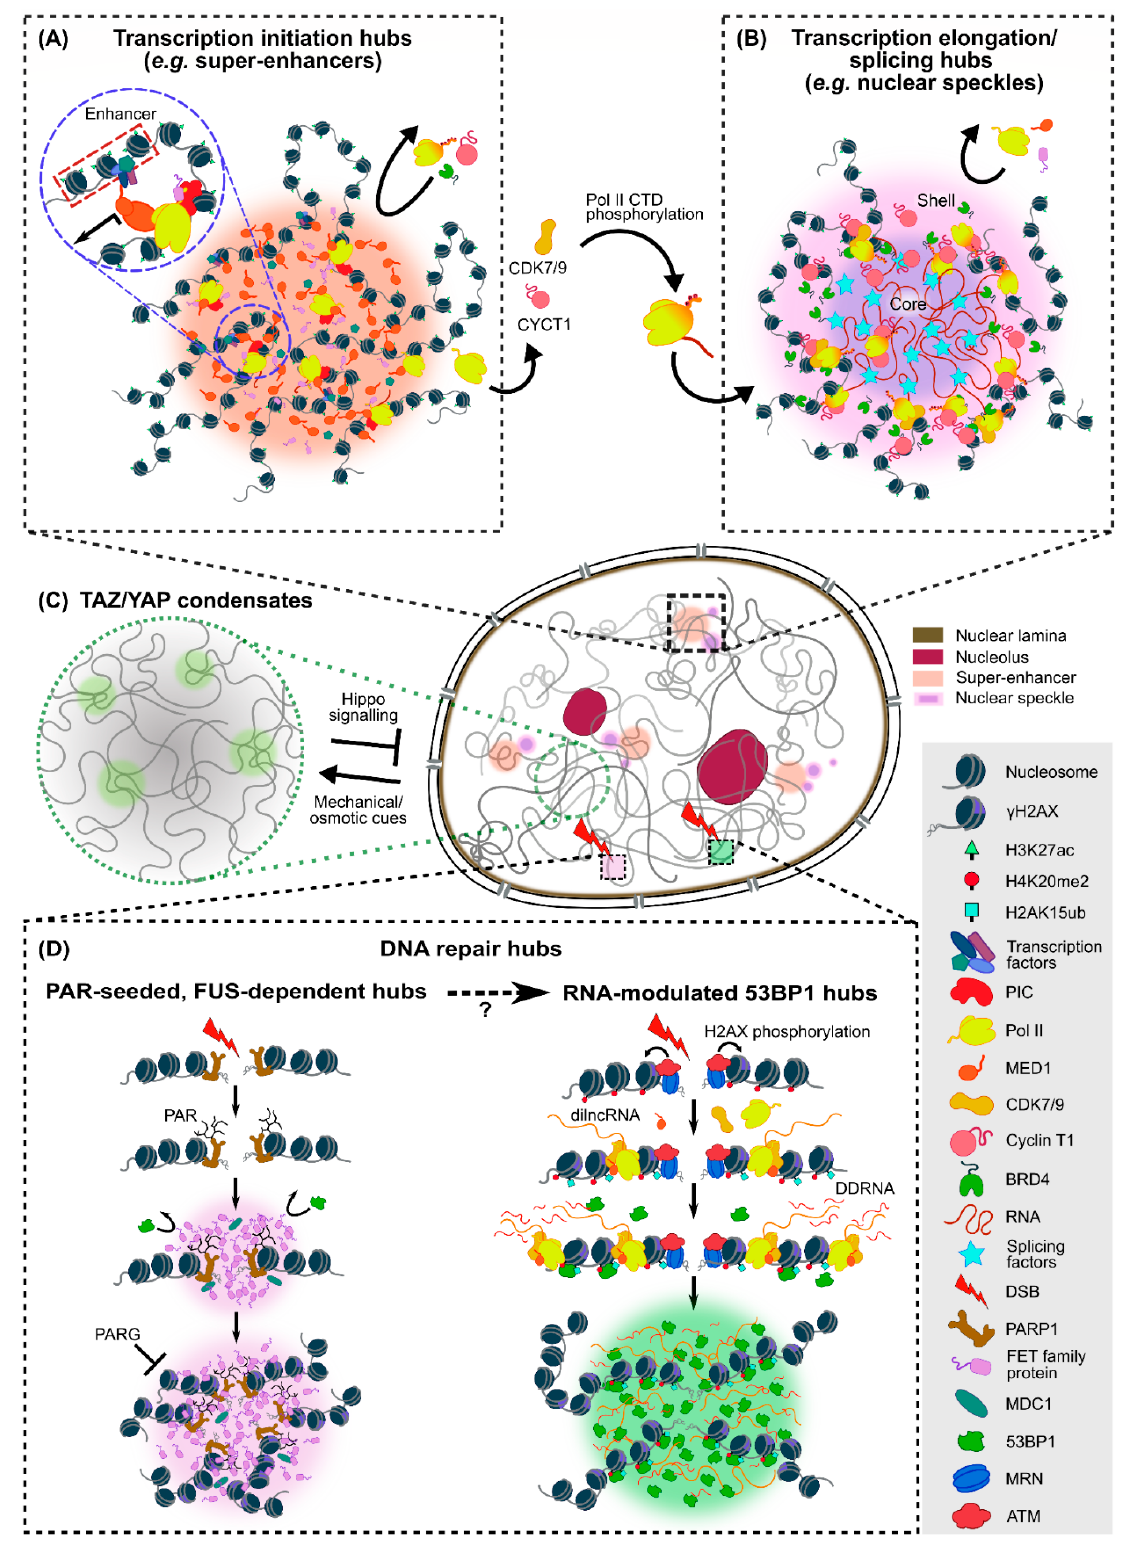
Figure 4. Phase separation-mediated small-scale chromatin-based condensates. ( A ) SE condensates serve as transcription initiation hubs that recruit TFs and coactivators (e.g., OCT4, c-MYC, KLF4 and MED1), which in turn recruit downstream transcriptional machineries. In particular, Pol II has a strong tendency to phase separate, but is excluded from these hubs upon phosphorylation of its